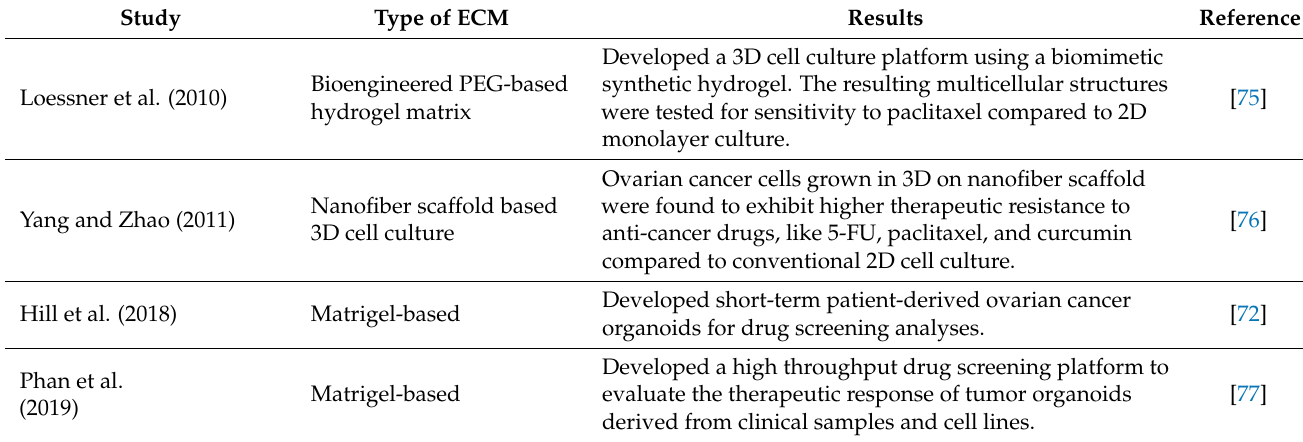
Table 5. Overview of organoid-based drug response assays in ovarian cancer.